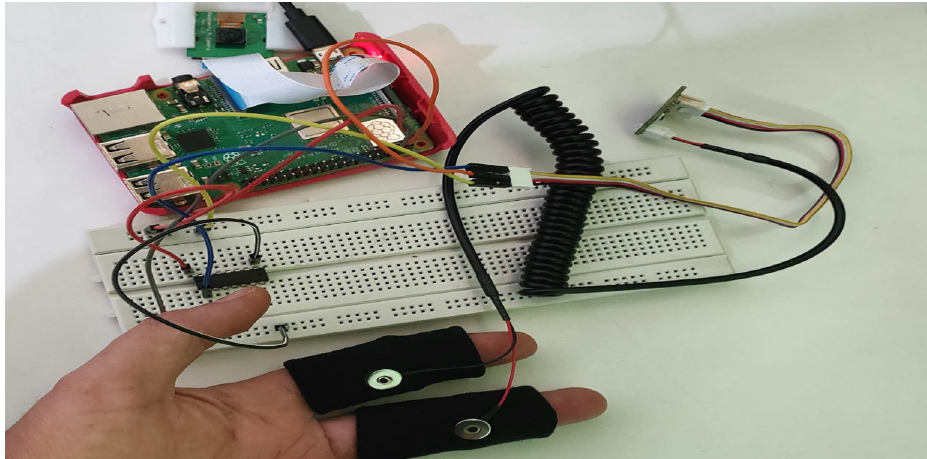
Figure 8. Raspberry Pi 3 B+ microcontroller with camera and sensor .